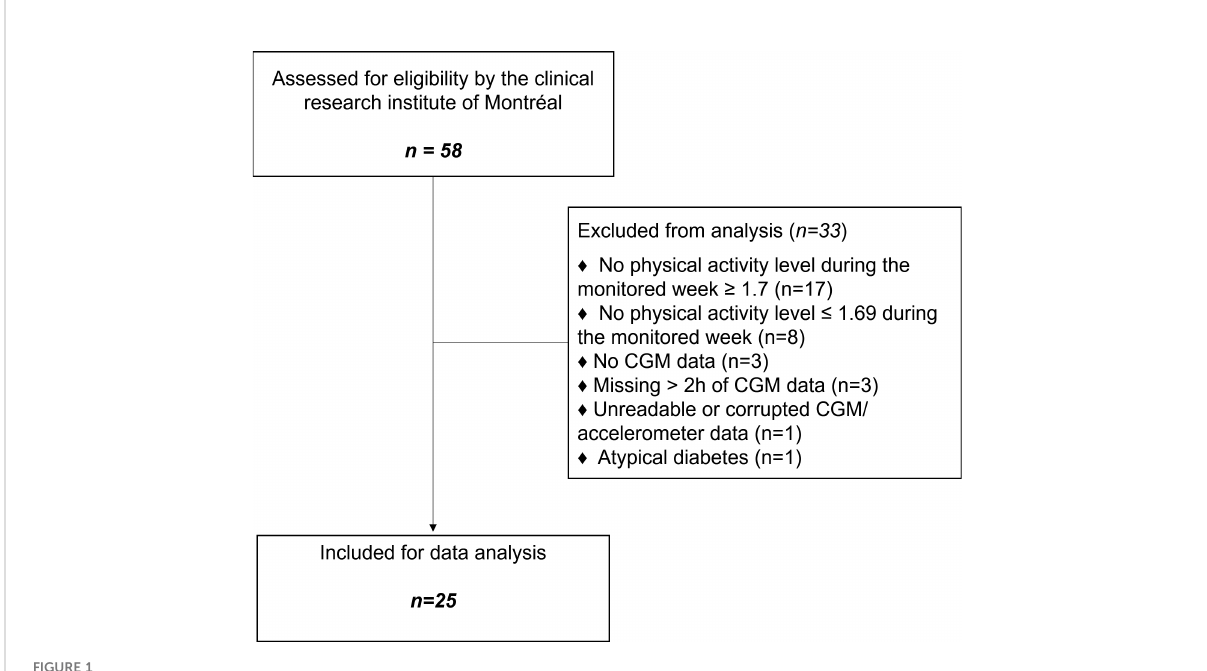
FIGURE 1 Consort fl ow diagram of the